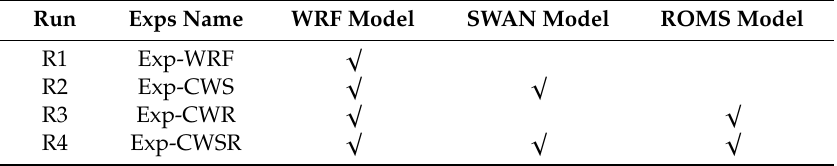
Table 1. The atmosphere–wave-ocean model considered in di ff erent numerical